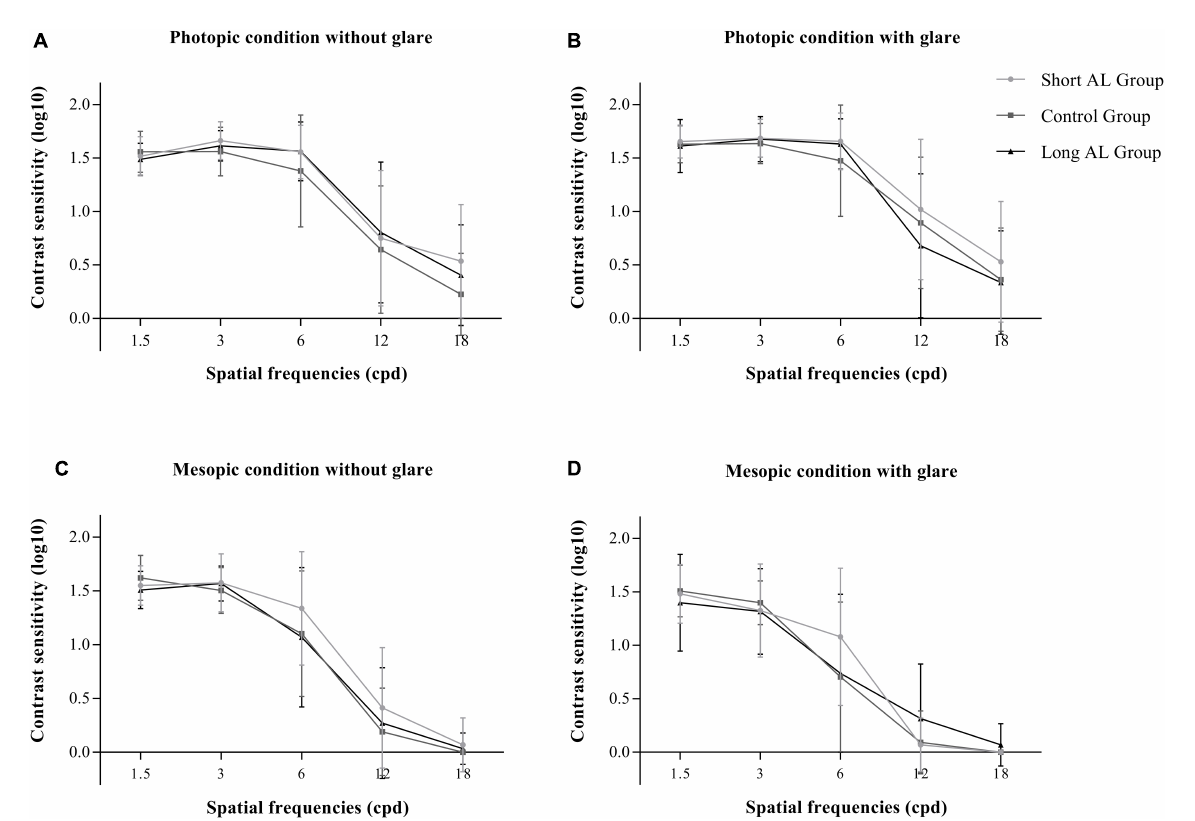
FIGURE3 The contrast sensitivity of three groups. (A) Photopic condition without glare; (B) photopic condition with glare; (C) mesopic condition without glare; (D) mesopic condition with glare. (AL, axial length; cpd, cycle per degree).